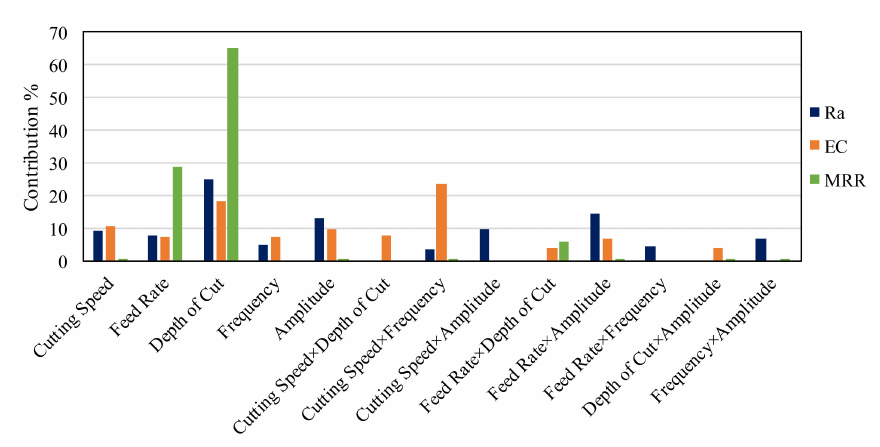
Figure 14. Contribution % of RUM input parameters on Ra, EC, and MRR.